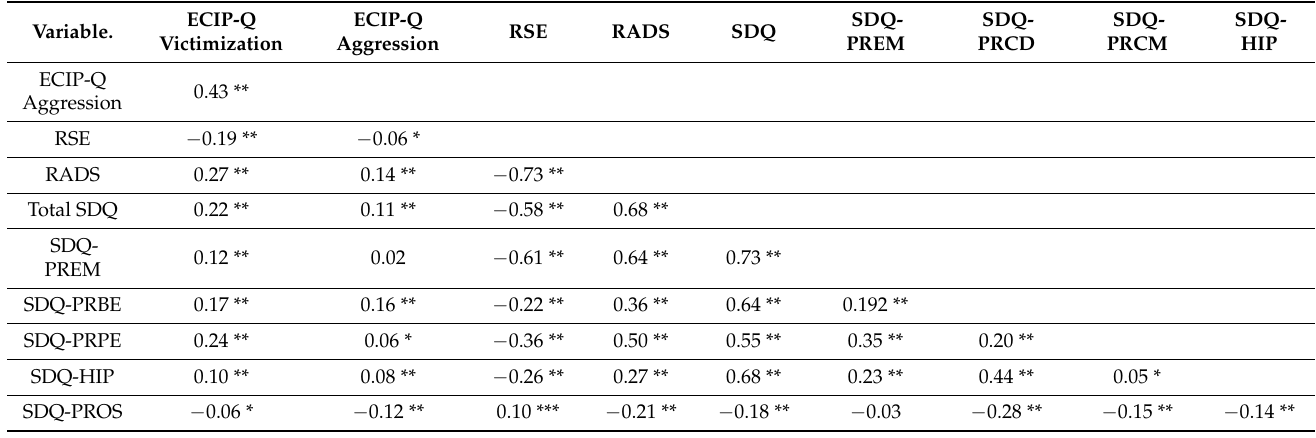
Table 3. Pearson correlations between the scores of the European Cyberbullying Intervention Project Questionnaire and different indicators of socio-emotional and behavioral